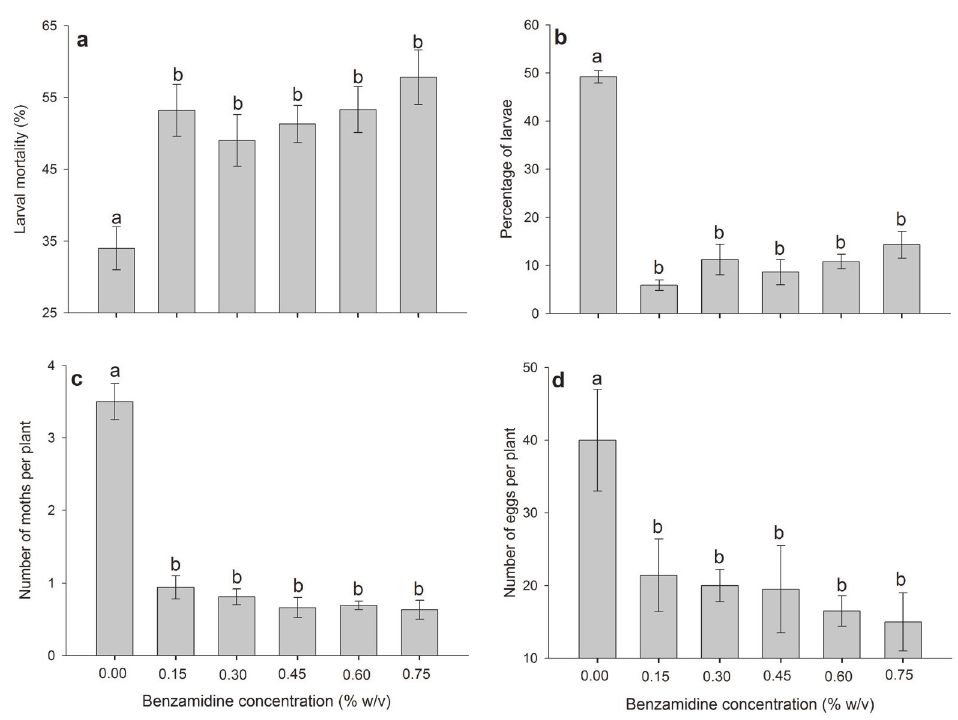
Figure 3 - Larval mortality ( a ), larval choice ( b ), preference of adult females ( c ) and eggs laid ( d ) by Anticarsia gemmatalis in soybean plants sprayed with PI benzamidine at different concentrations. Point and line indicate mean ± SE of six replicates in a and five in b - d . Different letters between concentrations indicate significant differences by the Holm–Sidak HSD test (p <